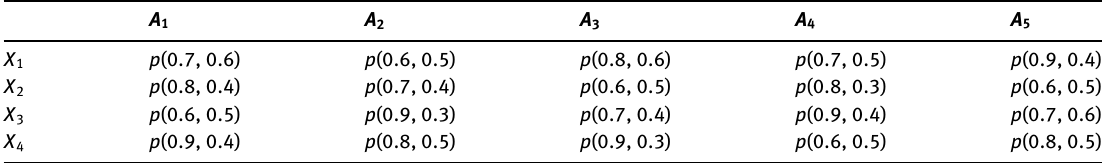
Table 5: Pythagorean Fuzzy Decision by Decision Maker d 2 .